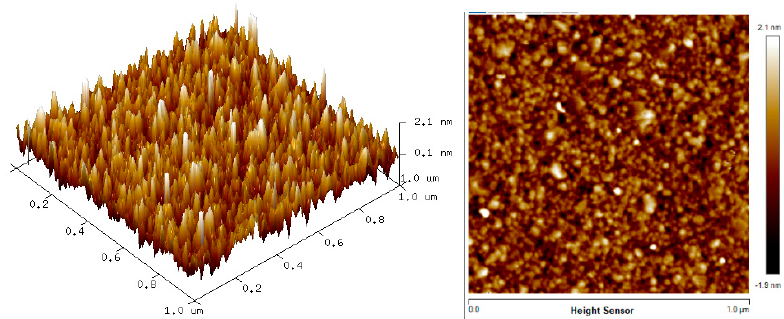
Figure 13. The AFM images of CTAB/HGQDs thin film after contact with the HMIs solution.